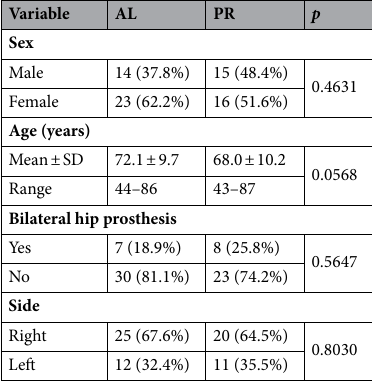
Table 1. Characteristics of patients undergoing hip revision (AL) and primary THA (PR). Data are expressed in absolute and relative frequencies